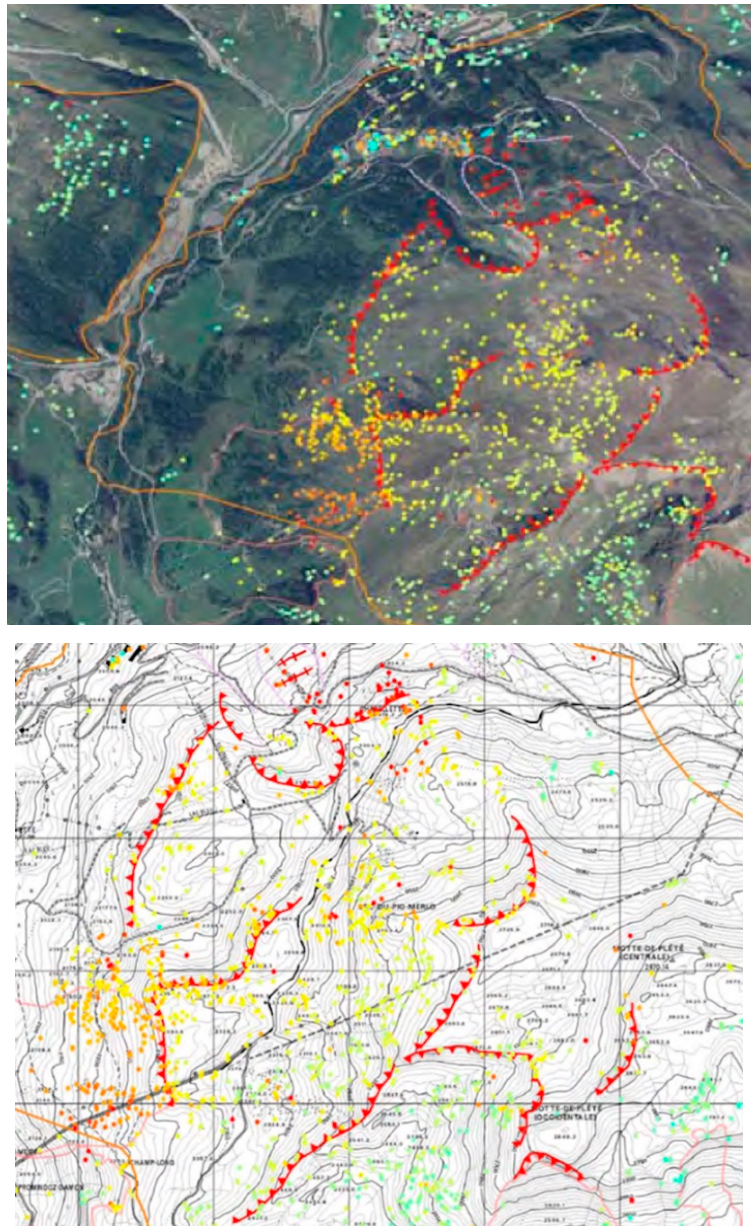
Figure 7. The deep earthflow in Cervinia.